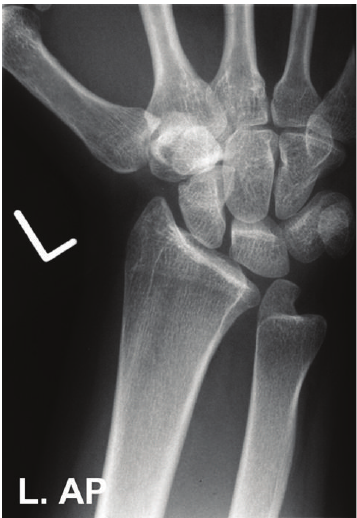
Figure 2: AP radiograph of the contralateral left wrist demonstrat- ing the abnormal appearance of the ulnar styloid in supination. The lie of the ulnar styloid in supination is identical to that of the injured right wrist.